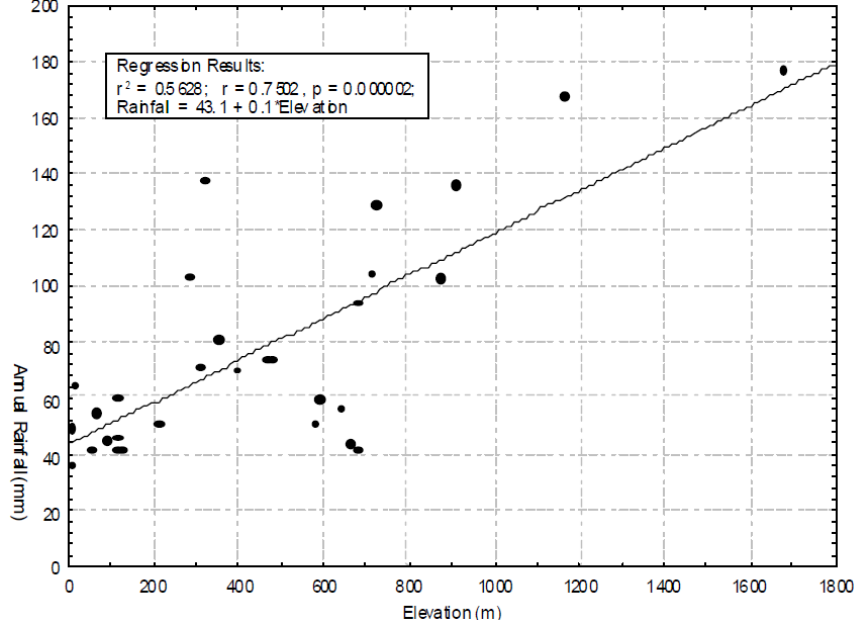
Figure 9. Rainfall-elevation relation in the study area